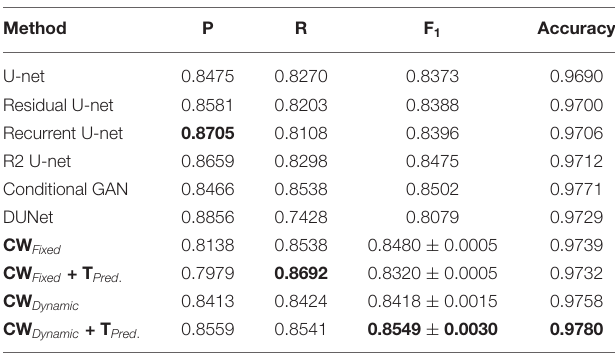
TABLE 2 | Results on STARE dataset.